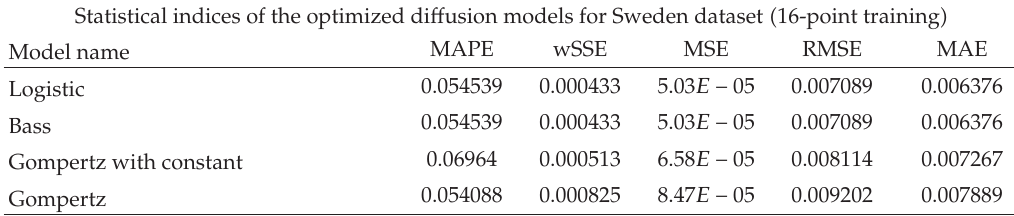
Table 16: Statistics for the optimized di ff usion models sorted by wSSE (cid:2) Sweden (cid:3) forecast period—2 years.